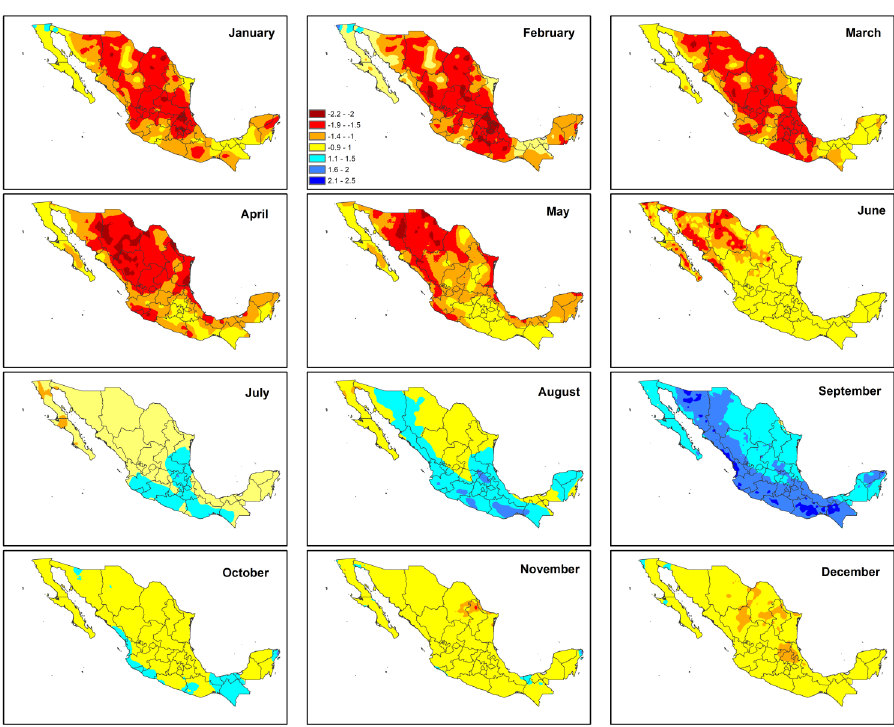
Figure 10. Drought monitoring based on TRMM 3B42 three-month Standardized Precipitation Index for 2011.